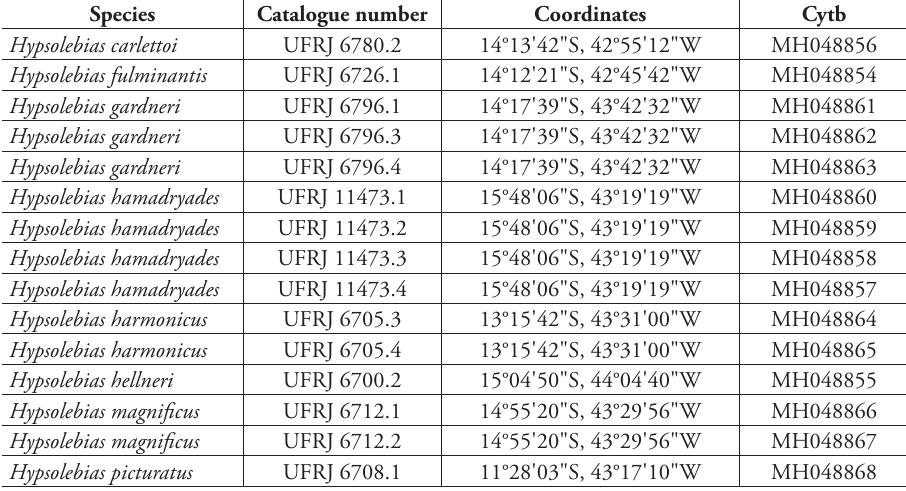
Table 1. List of specimens used in the molecular analysis, with their respective catalogue numbers, coor- dinates of the collecting site, and GenBank accession numbers for cytb sequences.